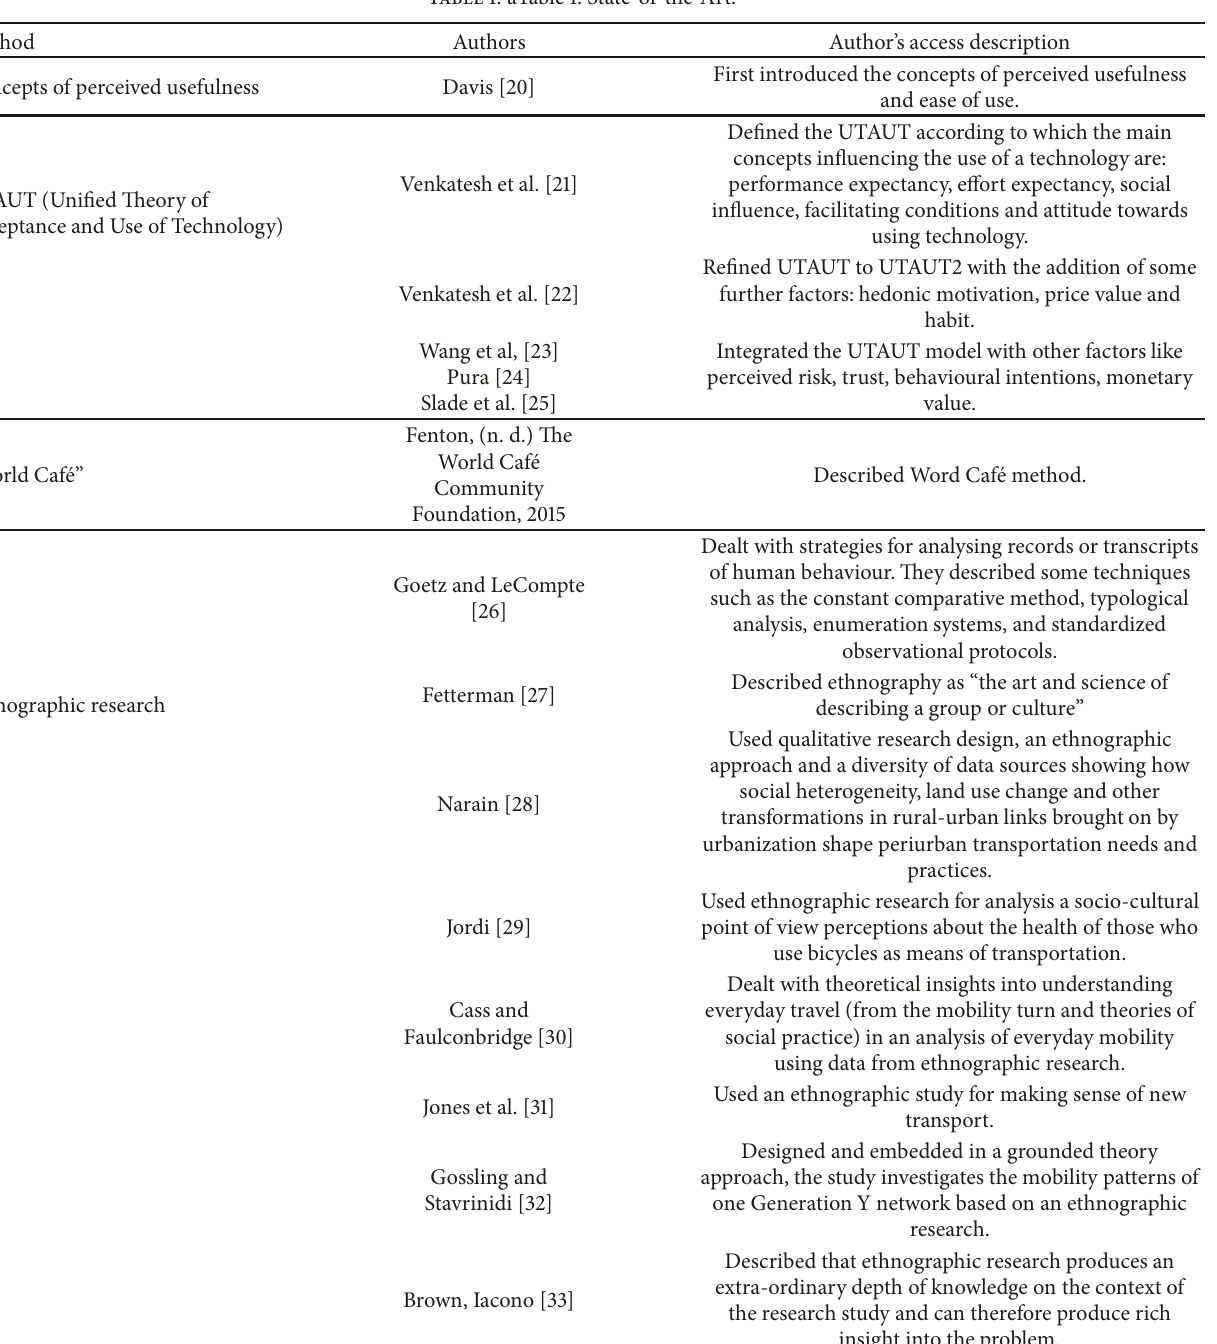
Table 1: aTable 1: